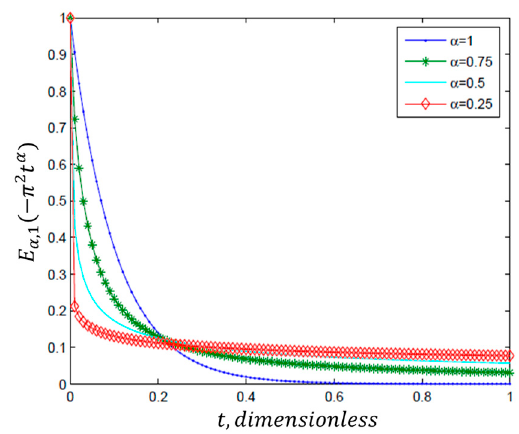
Figure 3. Decay rates comparison between Gaussian and anomalous diffusion for 2